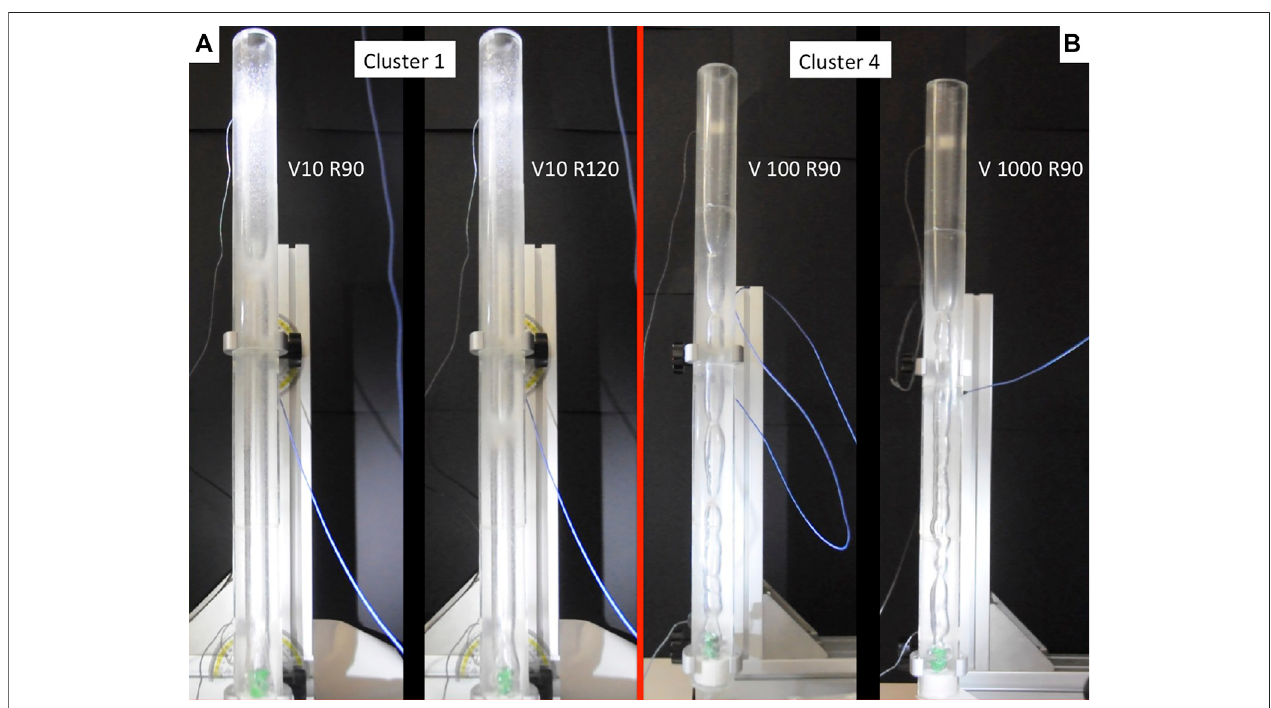
FIGURE10| Examples ofimagesoftheexperiments thatgeneratedeventsbelonging toCluster1 (A) and Cluster4 (B) .Vindicatestheanaloguemagmaviscosity in Pa s and R indicates the gas fl ow rate in 10 − 3 l/s. The tubes in the picture are 80 cm high and are smooth.